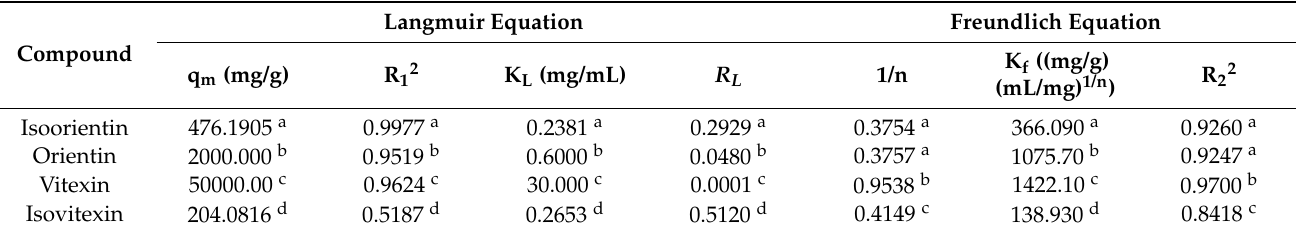
Values marked with different letters (a–d) indicate a comparison between compounds in each tested parameter. Each value is the average reading from three replicates (n = 3).